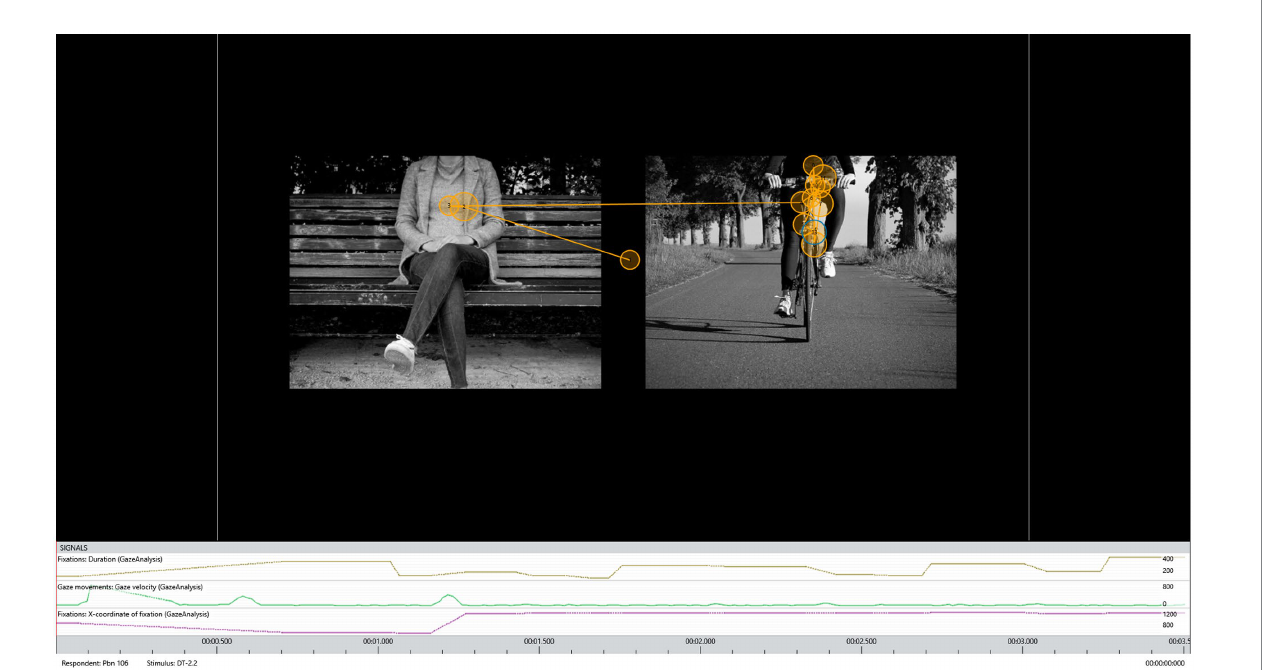
FIGURE 1 Representative gaze replay of a single participant with circles representing fixations and lines representing saccades. Fixation duration is indicated by circle size. Screenshot reproduced with permission from iMotions